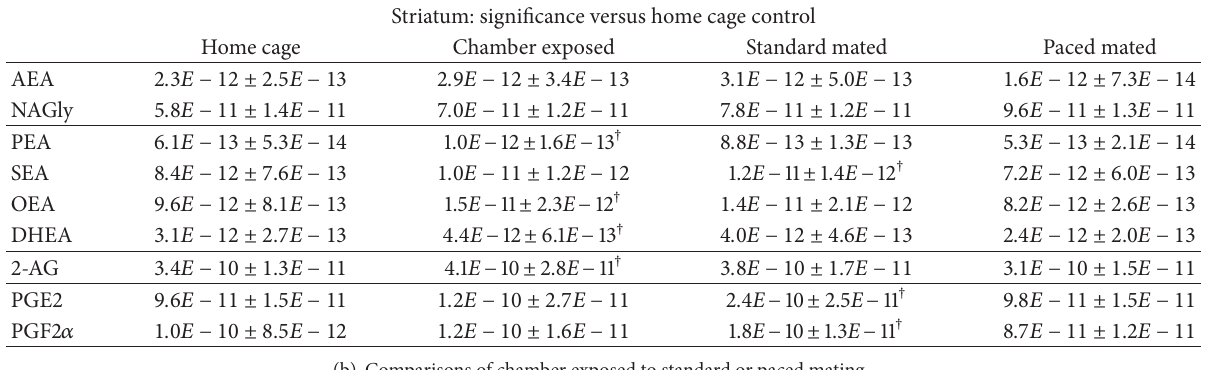
Table 6: Striatum